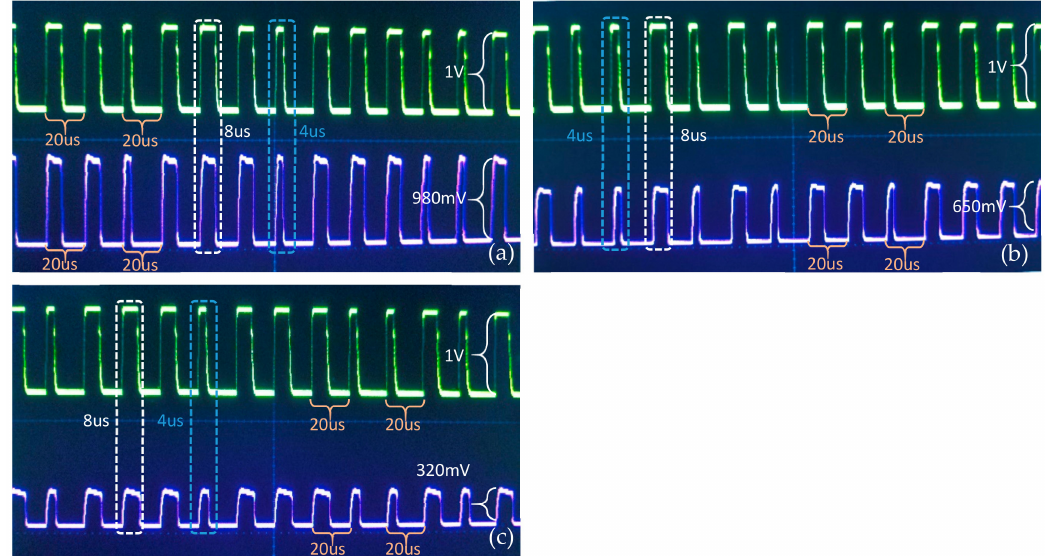
Figure 10. Waveform analysis of DIFRT ( a ) waveform of first relay node, ( b ) waveform of second relay node, and ( c ) waveform of final receiver (transmission rate = 50